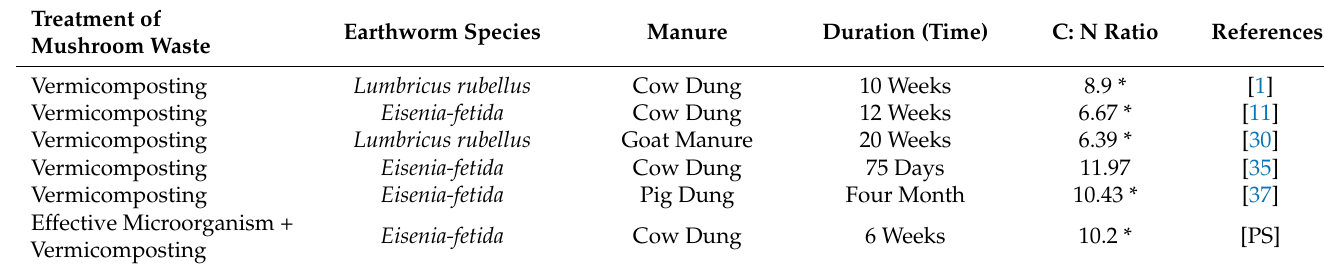
Table 4. Comparative results of the mushroom waste